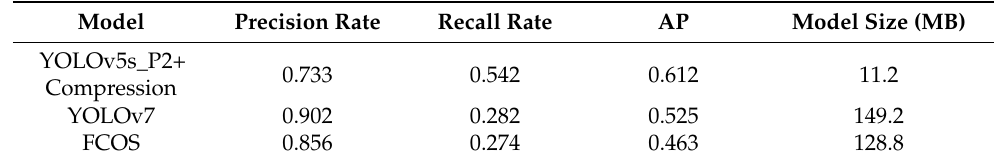
Table 3. Experimental results of different